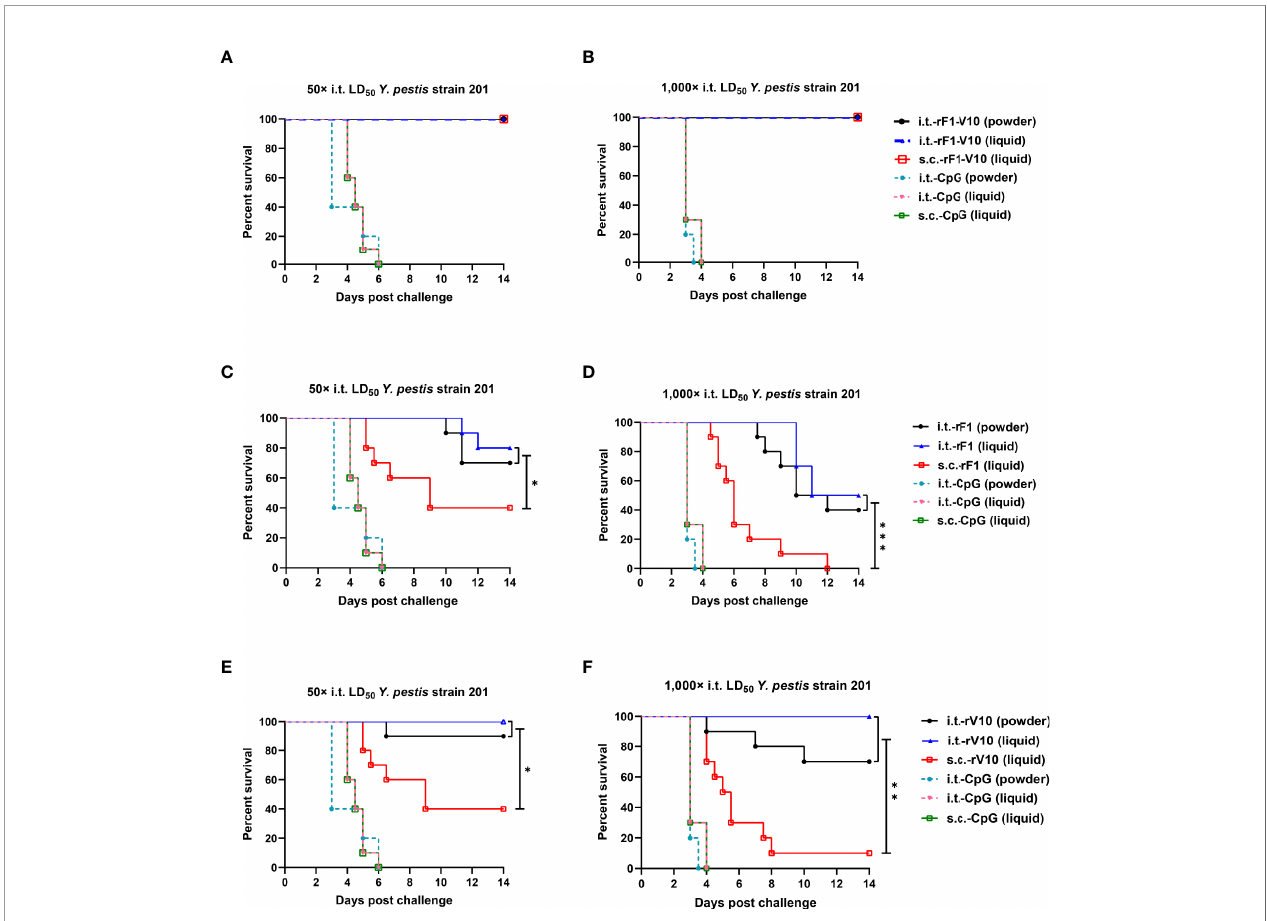
FIGURE 5 | Survival curves for mice challenged with aerosolized Y. pestis strain 201. Mice were immunized three times with rF1, rV10, or rF1-V10 in one of three formulations (powder; liquid; or powder reconstituted, not shown) via i.t. or s.c. (A, C, E) Mice (n = 10) immunized three times with (A) rF1-V10, (C) rF1, or (E) rV10 and then challenged with 50× LD 50 i.t. at 63 dppi. (B, D, F) Mice (n = 10) immunized three times with (B) rF1-V10, (D) rF1, or (F) rV10 and then challenged with 1,000× LD 50 i.t. For vaccines, inoculations are shown for powder and liquid formulations (powder reconstituted vaccine data are not shown) administered via i.t. or s.c. routes. Mortality data were analyzed using Kaplan-Meier survival analysis. * P < 0.05; ** P < 0.01; *** P <